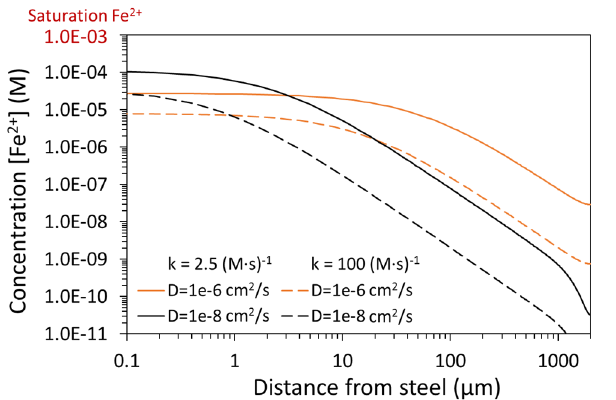
Figure 5. Concentration of dissolved Fe 2+ as a function of the distance from the steel surface (at t=50 h) in the extreme combinations of slow and fast rates of oxidation and diffusion, respectively. The Fe 2+ concentration distant from the steel surface is strongly influenced by these parameters, while the concentration at the steel surface only varies over 1 order of magnitude. It is important to note, however, that even for the combination of slow Fe 2+ oxidation and slow Fe 2+ diffusion, the Fe 2+ concentration never reaches the saturation level (still ca. 1 order of magnitude lower), thus, no Fe 2+ precipitation is expected to